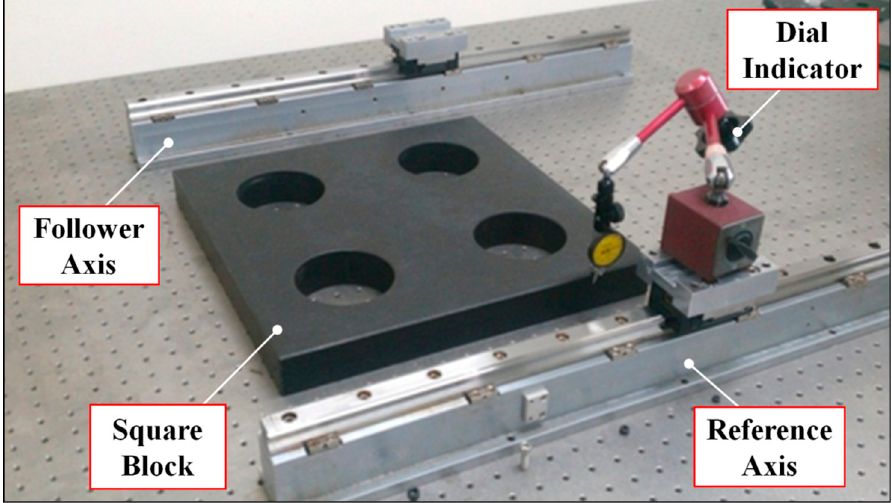
Figure 18. Verification setup of parallelism measurement using a square block.